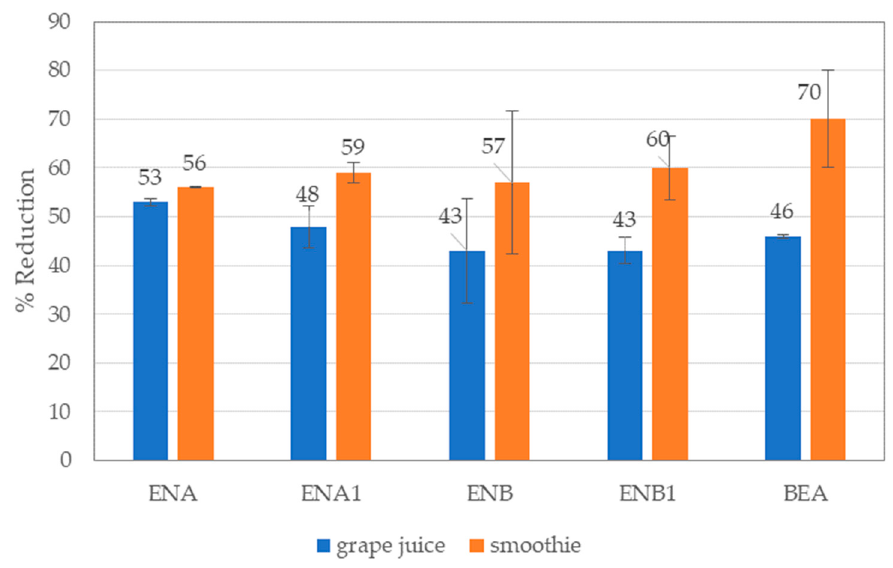
Figure 1. Percentage of reduction (%) of enniatins (ENs) and beauvericin (BEA) in grape juice vs. smoothie samples after pulsed electric fields (PEF) treatment.